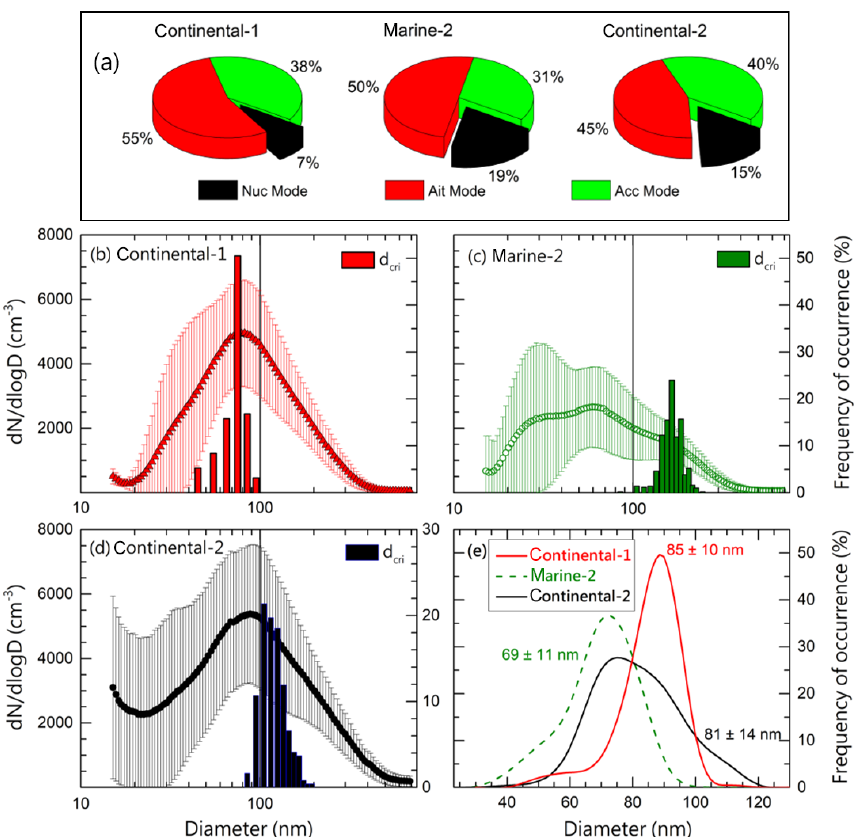
Figure 11. (a) Fraction (in %) of nucleation mode, Aitken mode, and accumulation mode particles during the observation periods. Aerosol mean number size distribution (with standard deviations) during (b) continental-1, (c) marine-2, and (d) continental-2 conditions. The bars in the same plots indicate the frequency distribution of critical activation diameters at 0.3% SS of the corresponding conditions (right axis). (e) Frequency distribution of the geometric mean diameter of the aerosol system during the observation